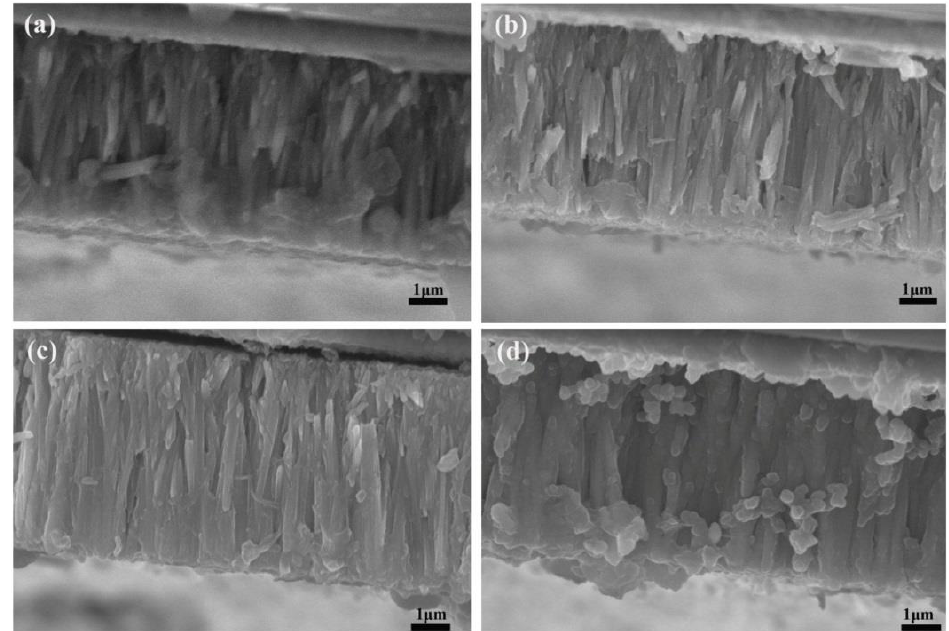
Figure 2. Cross-sectional SEM images of PPy-TiO 2 nanocomposites prepared by different deposition times, ( a ) 1PPy-TiO 2 , ( b ) 2PPy-TiO 2 , ( c ) 3PPy-TiO 2 , and ( d ) 4PPy-TiO 2 .